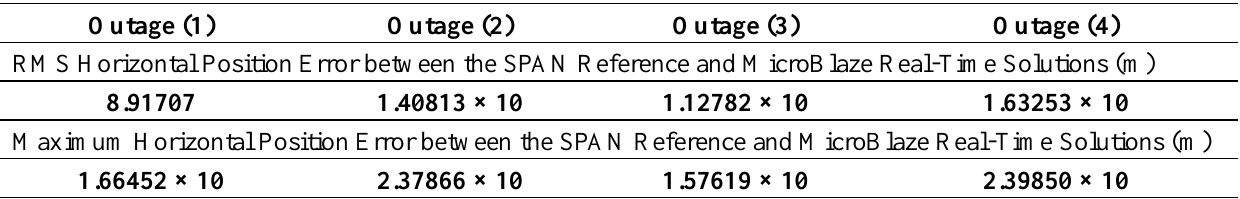
Table 9. RMS and Maximum Horizontal Position Error for the Four 60 seconds Outages Introduced in Land Vehicle Trajectory